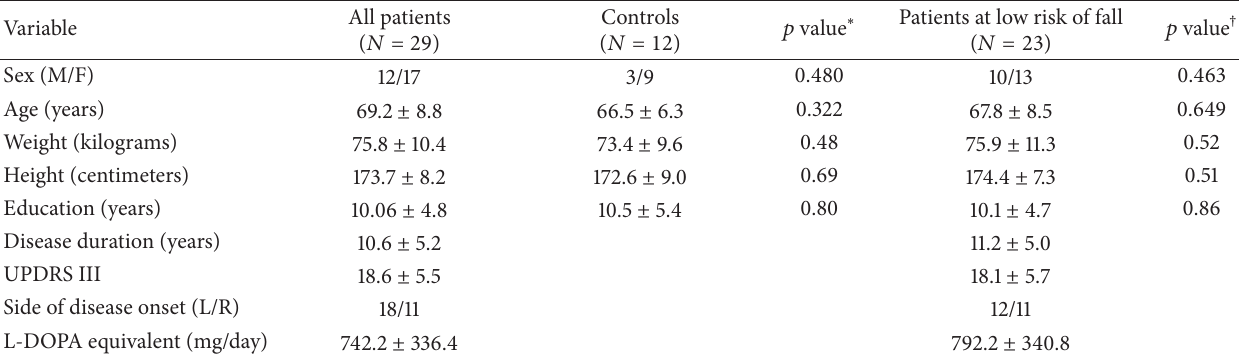
Table 1: Demographic and clinical characteristics of patients and controls.